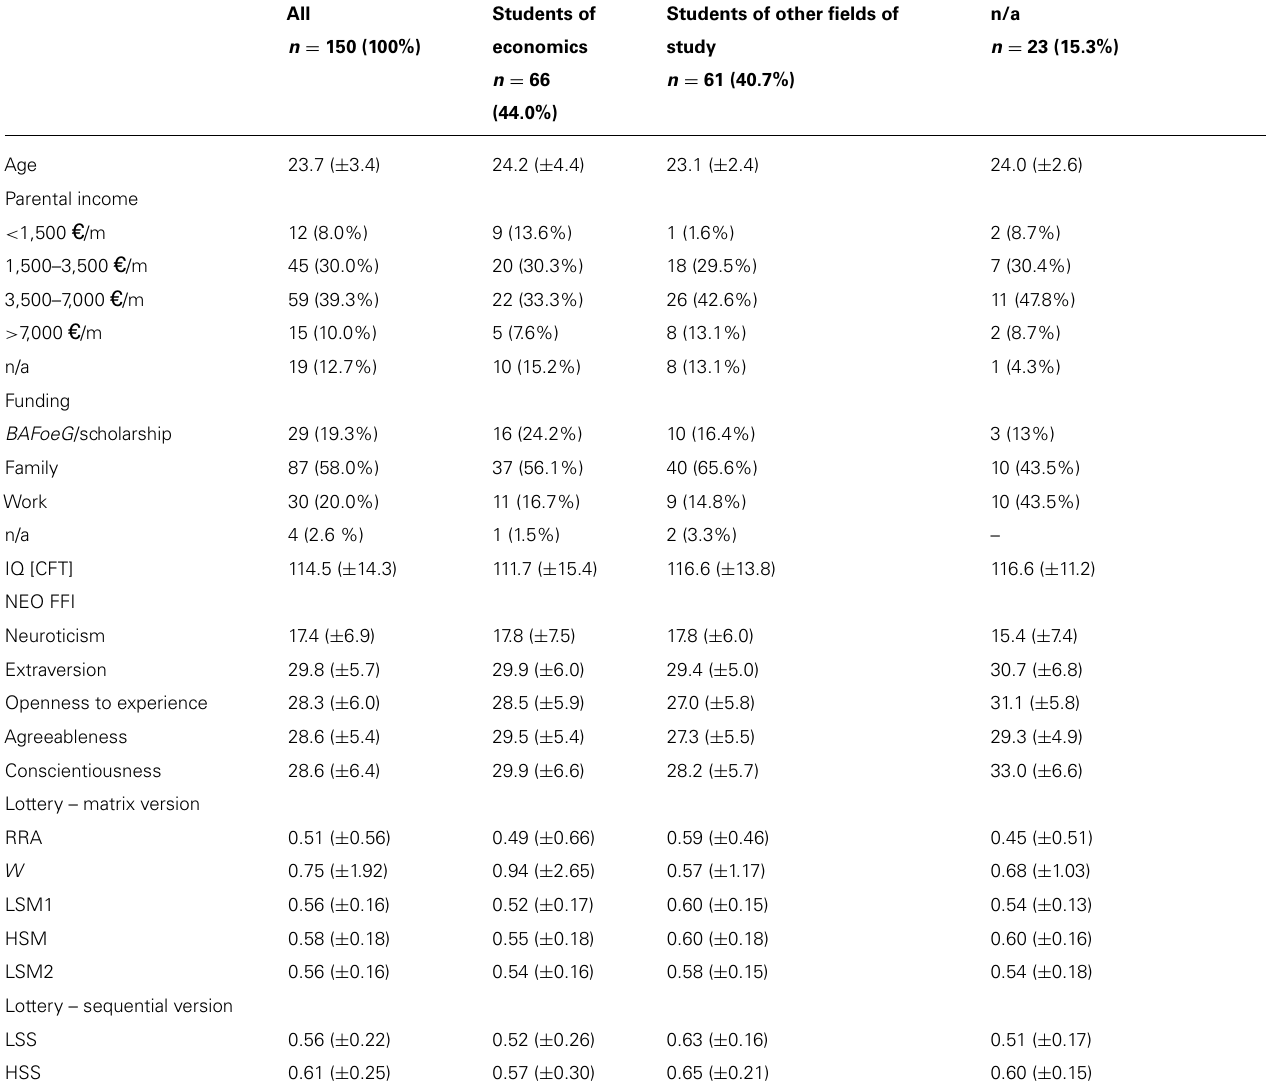
Table 1 | Demographics and basic outcome